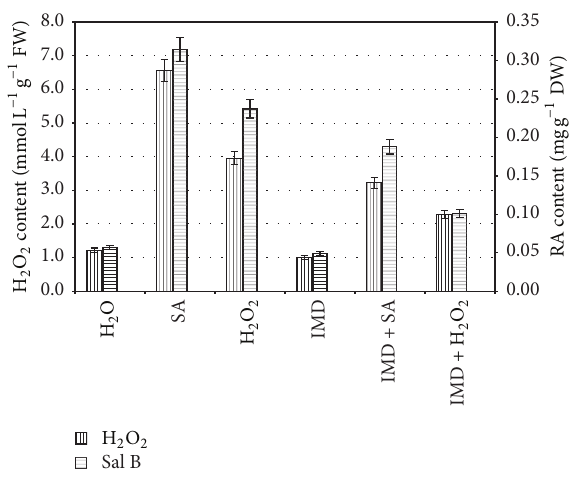
Figure 6: Inhibition of IMD on exogenous H 2 O 2 and/or SA in the generation of intracellular H 2 O 2 and the biosynthesis of RA in suspension cultured cells. 8-day-old suspension cultured cells treated with IMD 30 min before exogenous H 2 O 2 and/or SA treatment as indicated were harvested at 8 h (for H 2 O 2 analysis) and 2 d (for RA analysis) later, and the H 2 O 2 and Sal B contents were then determined. The Salicylic acid concentration is 22.5 mg/L. The exogenous H 2 O 2 concentration is 10mM. The IMD concentration is 100 𝜇 M. Values are means of three independent experiments. Bars represented standard